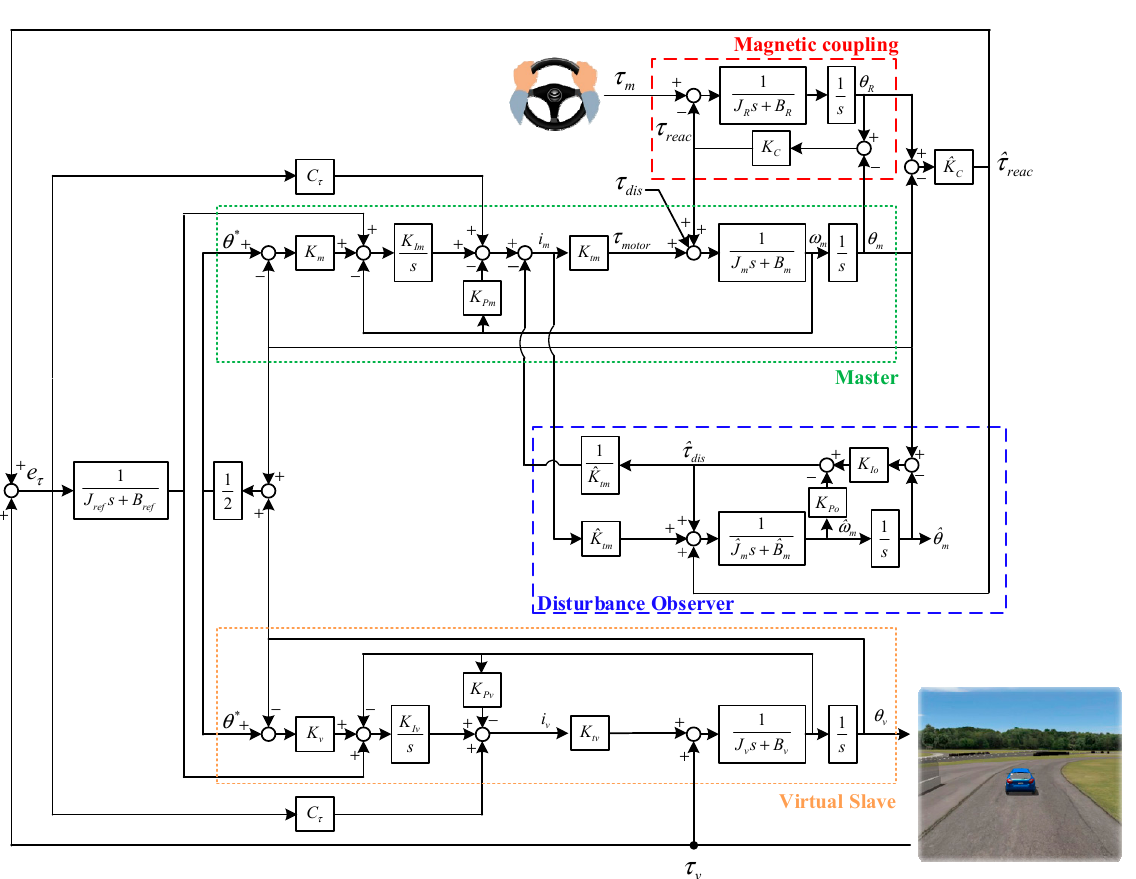
Figure 8. Block diagram of the proposed bilateral control configuration.